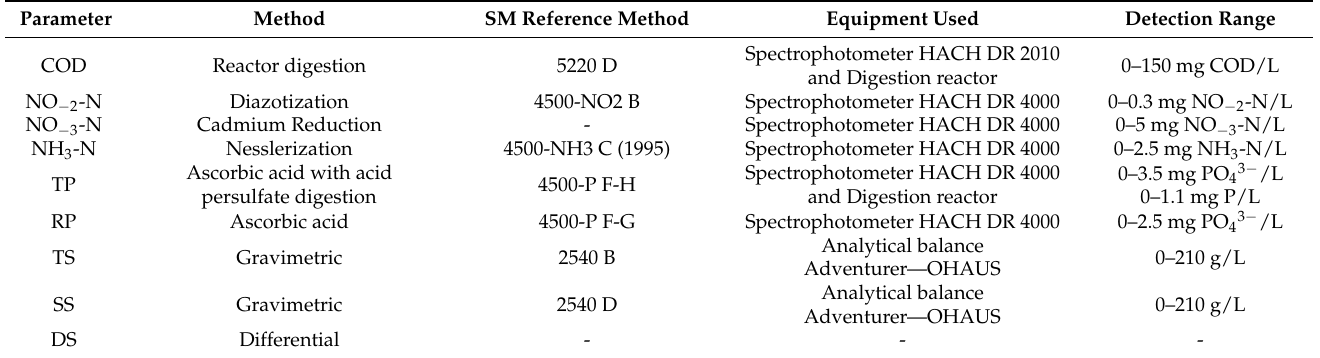
Table 1. Methods, equipment, and ranges for the analysis of water